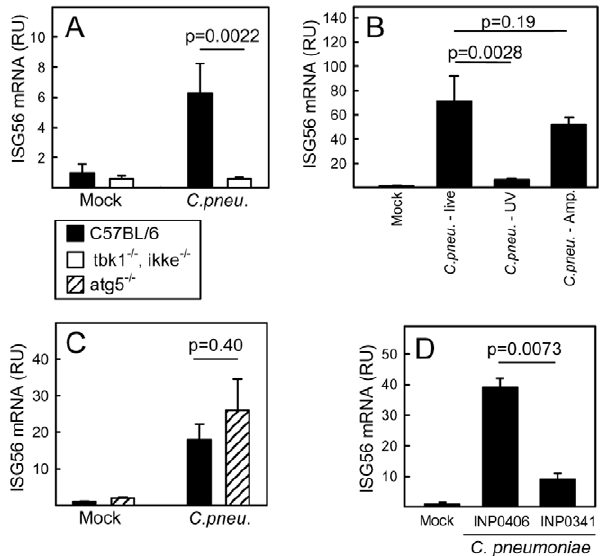
Figure 3. Induction of ISGs by Chlamydia pneumoniae is dependent on TBK1/IKK e , bacterial replication and the T3SS. (A, C) WT, tbk1 2 / 2 ikke 2 / 2 and atg5 2 / 2 MEFs were infected with C. pneumoniae , MOI 5, for 36 h before harvest of total RNA. (B) WT MEFs were infected with live or UV-inactivated C. pneumoniae (CFU/cell 5) in the presence and absence of ampicillin (20 m g/ml) as indicated. (D) The cells were treated with INP0341 (60 m M), INP0406 (60 m M) or DMSO (vehicle) and infected with C. pneumoniae , MOI 5. Total RNA was harvested 36 hrs post-infection. (A–D) Levels of ISG56 mRNA were determined by real-time PCR. The measured ISG56 mRNA levels were normalized to b -actin, and data are presented as means of triplicate cultures + / 2 st.dev. Similar results were obtained in 2–3 independent experiments. RU, relative